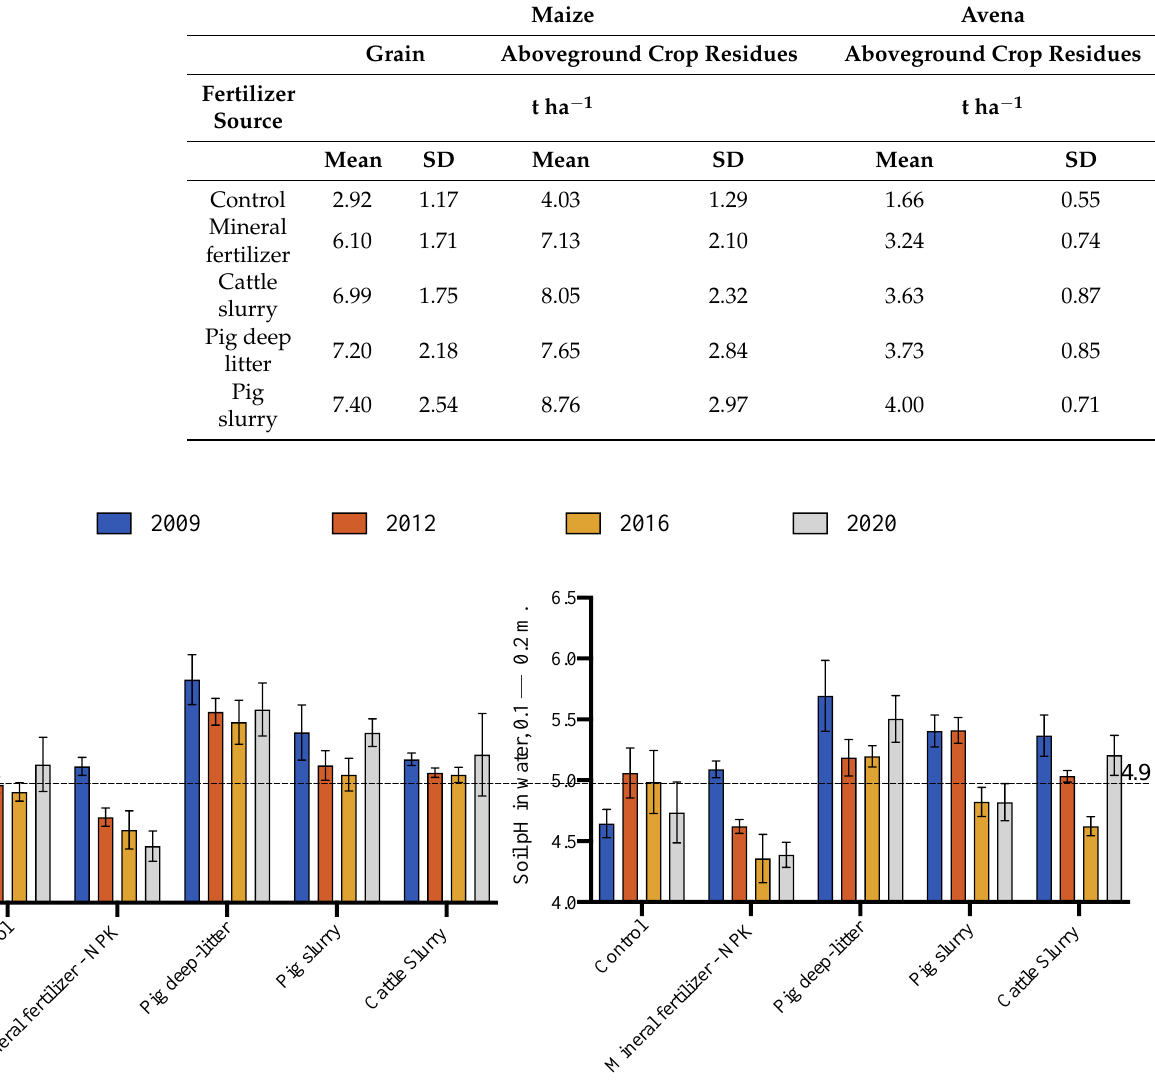
Figure 1. Change in soil pH in the 0–0.1 m and 0.1–0.2 m layers between soil sampling periods as impacted by fertilizer sources. Horizontal line shows initial soil pH in 2004. The results shown in the figure are the arithmetic mean and standard error based on pH